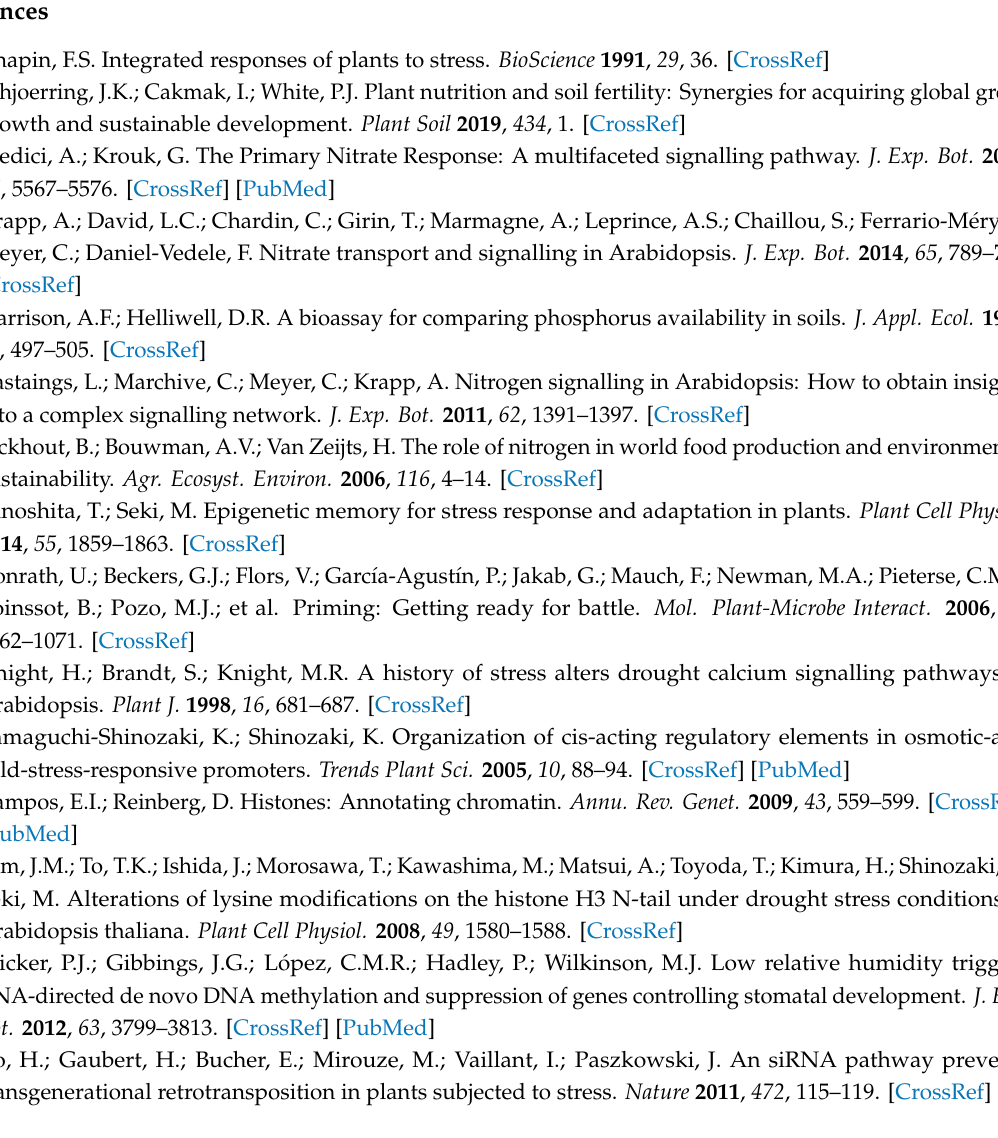
Figure S1. The fresh weight (FW) of shoots and roots and root volume of arabidopsis plants are shown. The values are means + SD, small letters refer to statistical significance (one-way ANOVA, Student-Newman-Keuls method, N = 3, p-value < 0.05). Figure S2. The nitrogen (N) and carbon (C) content and C to N ratio (C / N) are shown for Arabidopsis plants of first, second and third generations. The values are means + SD, small letters refer